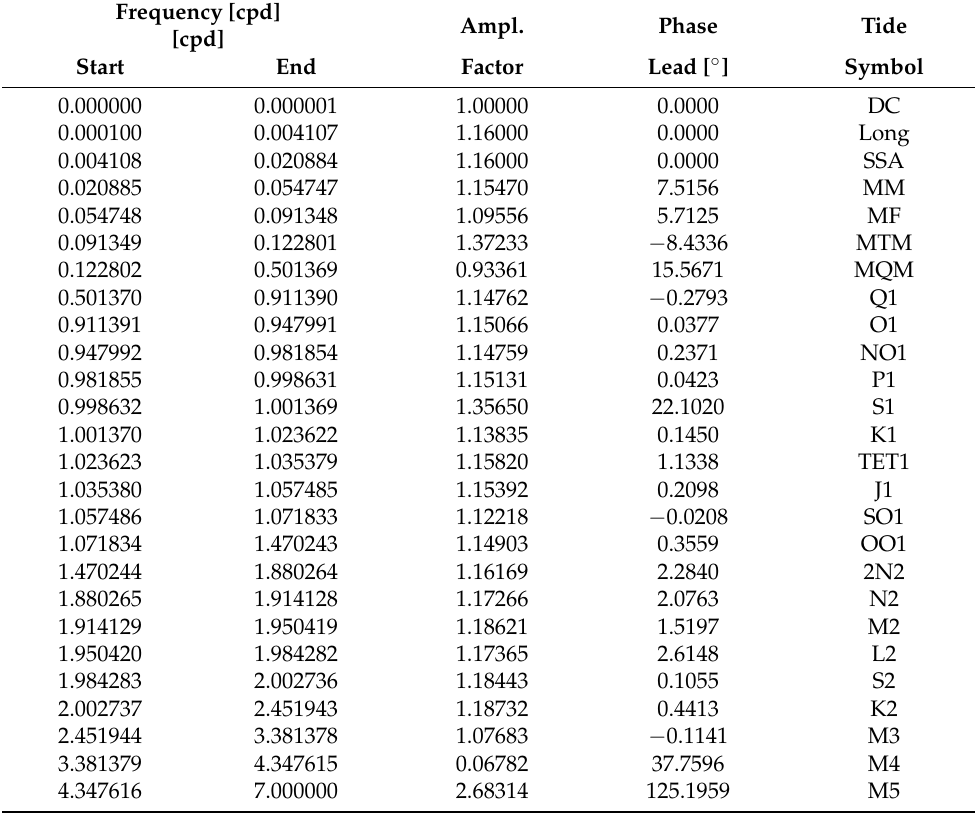
Table A1. Applied Earth tide data set with amplitude factors and phase shifts observed at ZUGOG with superconducting gravimeter OSG#052. The tidal waves with periods longer than 1 month are considered with the general values 1.160 (Ampl. factor) and 0.000 ◦ (Phase lead). The parameter of the partial tides M4 and M5 are assumed to be caused by non-linear shallow water tides of unknown source. The amplitudes of the M4 and M5 body tides are almost zero which is why these tides do not have any significance for absolute gravimetry. Ampl.